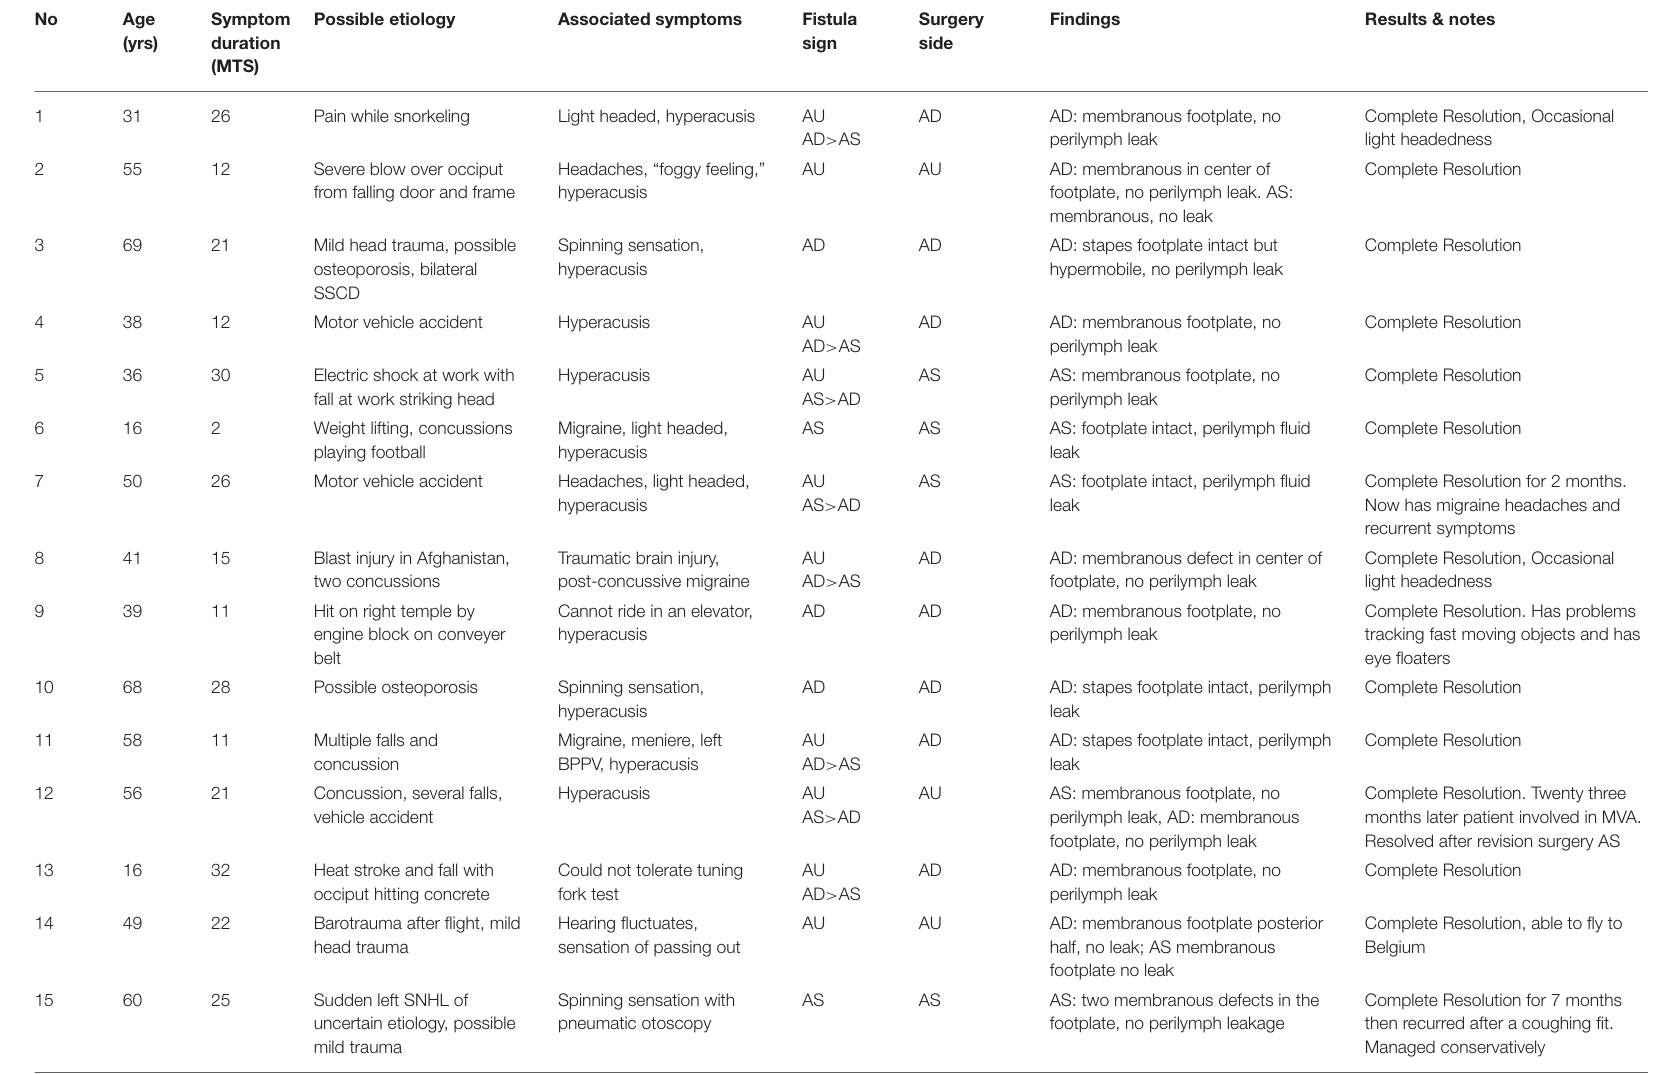
TABLE 1 | Demographics surgical findings and